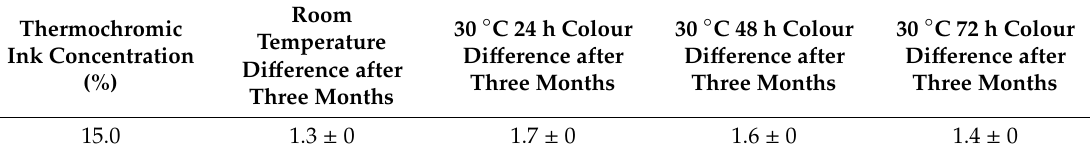
Table 7. Effect of time on colour difference of thermochromic waterborne finish coating. Table 7. E ff ect of time on colour di ff erence of thermochromic waterborne finish coating.